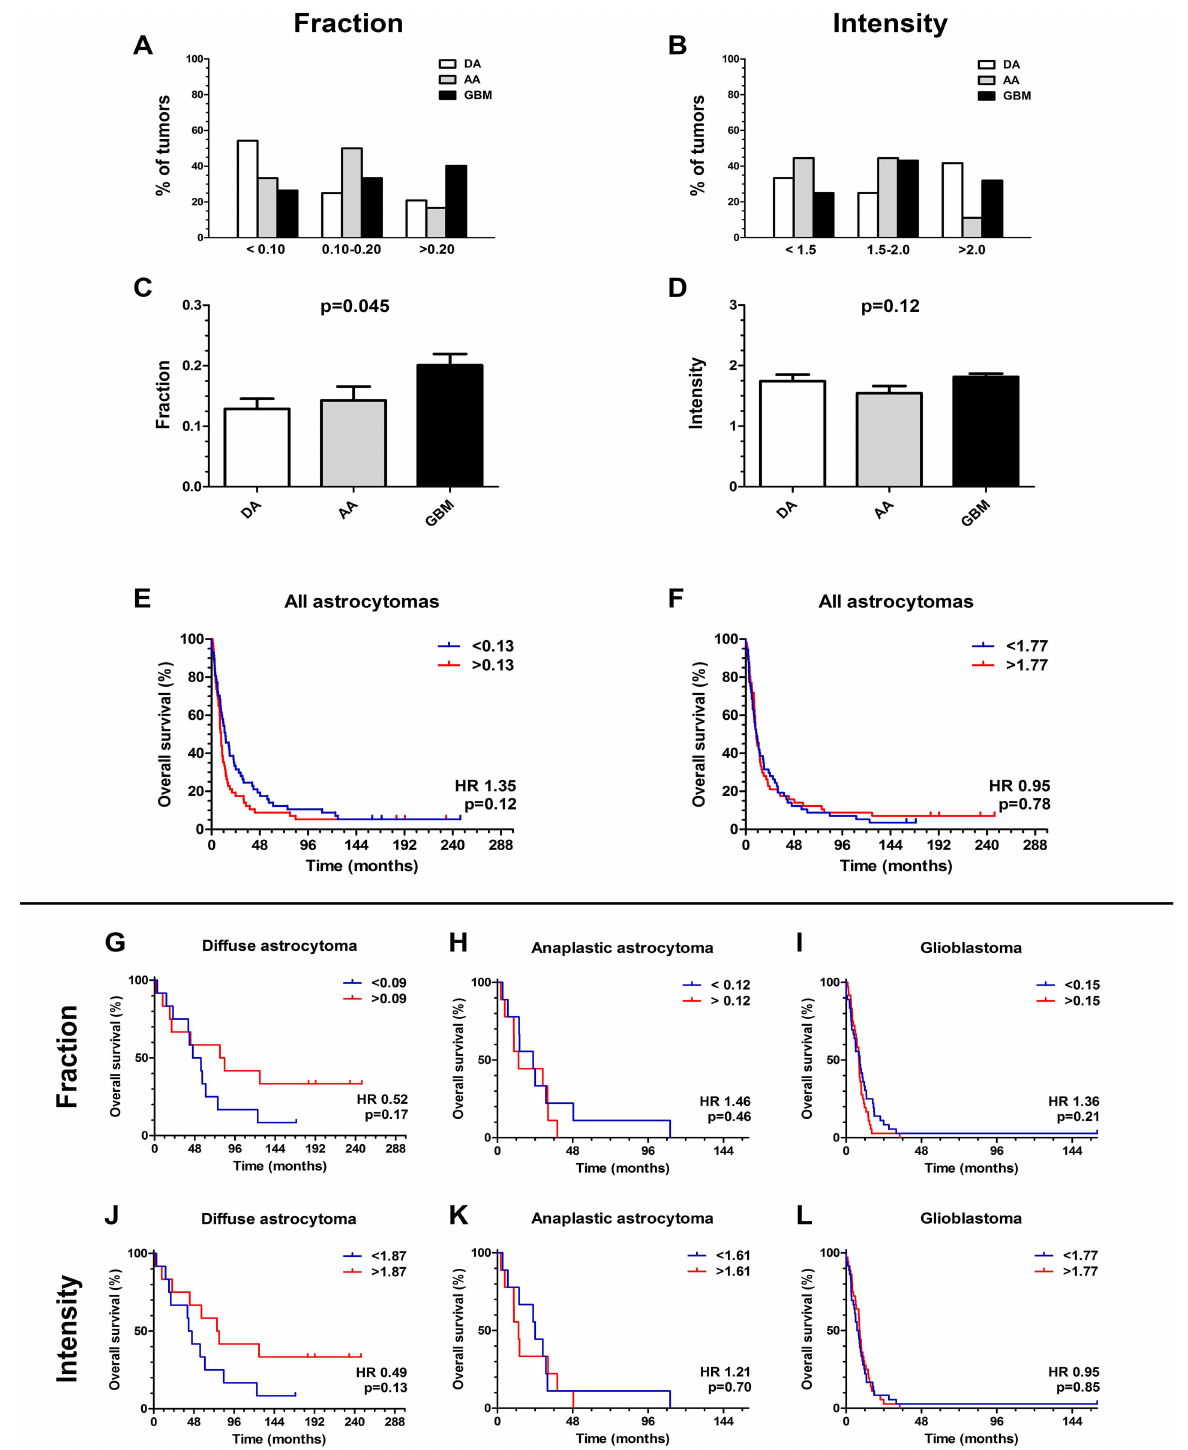
Fig 3. Distribution of Oct-4 staining and Kaplan Meier Survival analysis. For tumor cell fraction, glioblastomas were the most frequent tumors in the high expressiongroup ( > 20%),whereasanaplasticastrocytomas were the most frequent tumors in the group with medianexpressionlevel (10–20%).(A) Over 50% of diffuse astrocytomas was locatedin the low expressiongroup (0–10%), where also the lowest percentage of glioblastomas was located. (B) For tumor cell staining intensity no clear pattern of distributionwas found. (C) ComparingOct-4 expressionwith grade there was a significantassociationof Oct-4 fraction with grade (p = 0.045), (D)